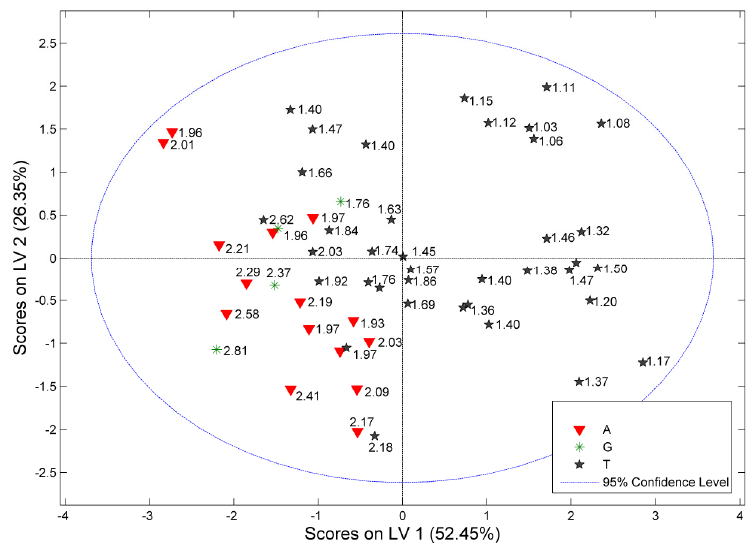
Figure 3. PLS − DA: score plots for C. incanus parameters with the values of the TPC:TFC ratio (A, Albanian; G, Greek, T, Turkish plant Albanian; G, Greek, T, Turkish plant material).